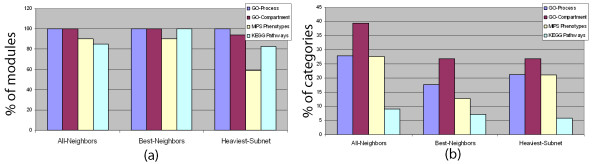
Performance of the three proposed heuristic in terms of annotation enrichment. See Figure 3 for further details.